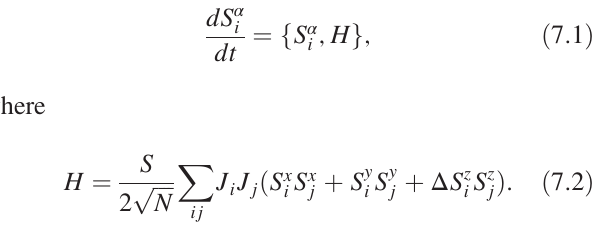
FIG. 6. (a) The sensitivity d ð t Þ from Eq. (7.7) geometrically averaged over 10 4 disorder realizations f J function of time for a system of N ¼ 128 classical spins. After nonuniversal dynamics at early times, we find an exponential growth at later times for Δ ¼ − 0 . 5 (red curve), Δ ¼ 0 . 5 (blue curve), and Δ ¼ 1 . 5 (green curve). (Inset) The square root of the same quantity, ffiffiffiffiffiffiffiffiffiffiffiffiffiffiffiffiffiffiffiffiffiffiffiffiffiffiffiffiffiffiffiffiffiffiffiffi p ) namely, exp ( h log d ð t Þi , at the two integrable points, Δ ¼ 0 . 0 (cyan curve) and Δ ¼ 1 . 0 (magenta curve). We obtain an almost J; S perfect straight line, which indicates that d ð t Þ ∼ t 2 , as expected for an integrable system. (b) Lyapunov exponent h λ i disorder realizations and initial states as a function of the anisotropy Δ for different systems consisting of N ¼ 16 (red circles), N ¼ 128 (blue circles), and N ¼ 1024 (green circles) classical spins. (Inset) Disorder-averaged Lyapunov exponent h λ i system size N for Δ ¼ 0 . 1 (red squares), Δ ¼ 0 . 3 (blue squares), and Δ ¼ 0 . 5 (green